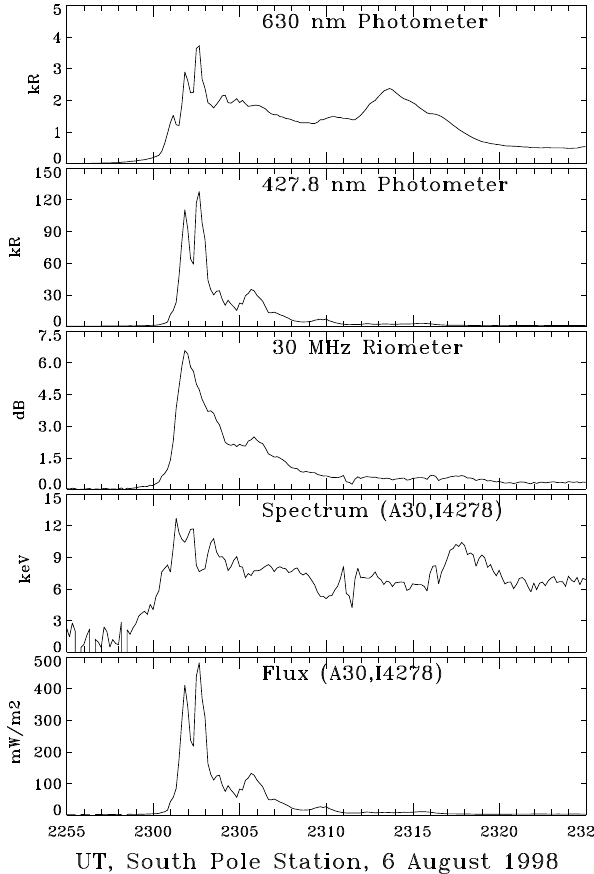
Fig. 10. Ground-based data from the South Pole and model calcu- lations of the spectral characteristics of the precipitating electrons. Panel 1: 630 nm photometer data. Panel 2: 427.8 nm photome- ter data. Panel 3: 30 MHz broad-beam riometer absorption inten- sity. Panel 4: Characteristic energy of the precipitating electrons obtained from a series of model calculations shown in Fig. 11. Panel 5: Energy flux of the precipitating electrons from aforementioned model